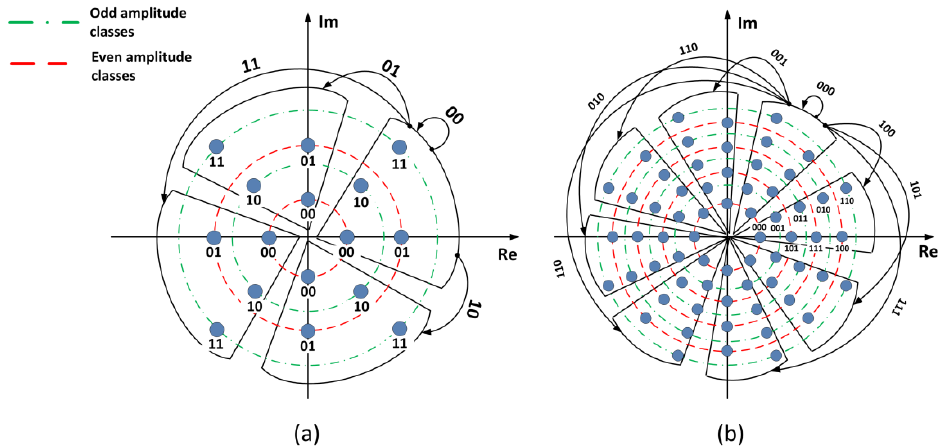
Figure 1. ( a ) Distribution of the constellation points in a C-16QAM constellation. ( b ) Distribution of the constellation points in a C-64QAM. The bit mapping, differential sector encoding, and symbol amplitude classes are also illustrated for both cases.